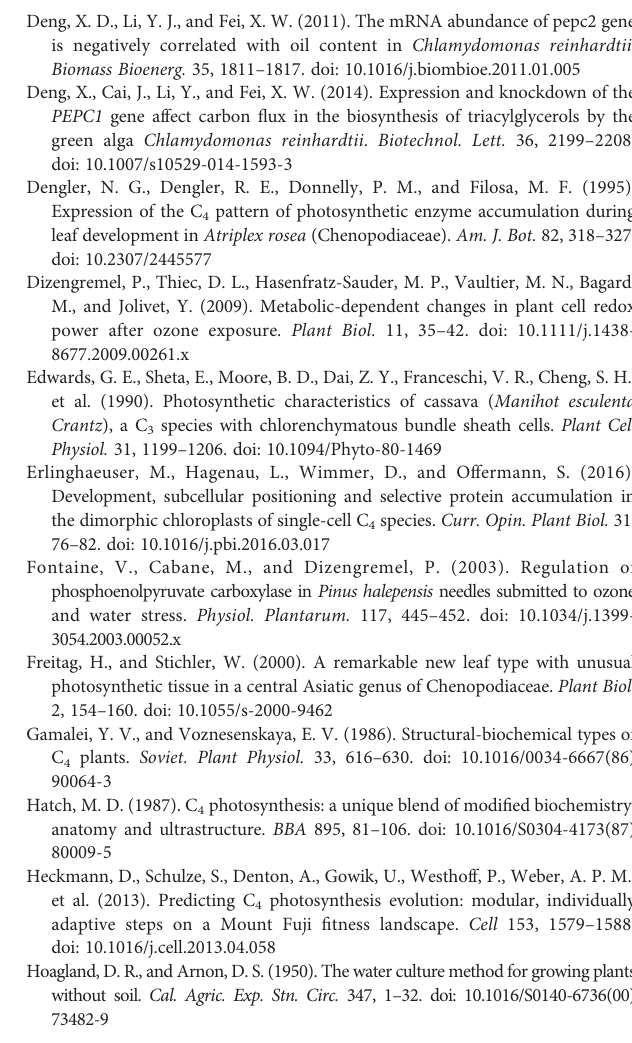
SUPPLEMENTARY FIGURE 2 | The developmental stage and morphology of S. ferganica in natural habitats. (A) Early seedling with two cotyledons only; (B) Seedling developed with small leaves covered with white, thick, long, and soft trichomes; (C) Plant withmany branches and leaves covered withwhite, thick, long, and soft trichomes; (D) Plant initiates blossom covered with much thinner and shorter trichomes on leaf; (E) Plant at full blossom